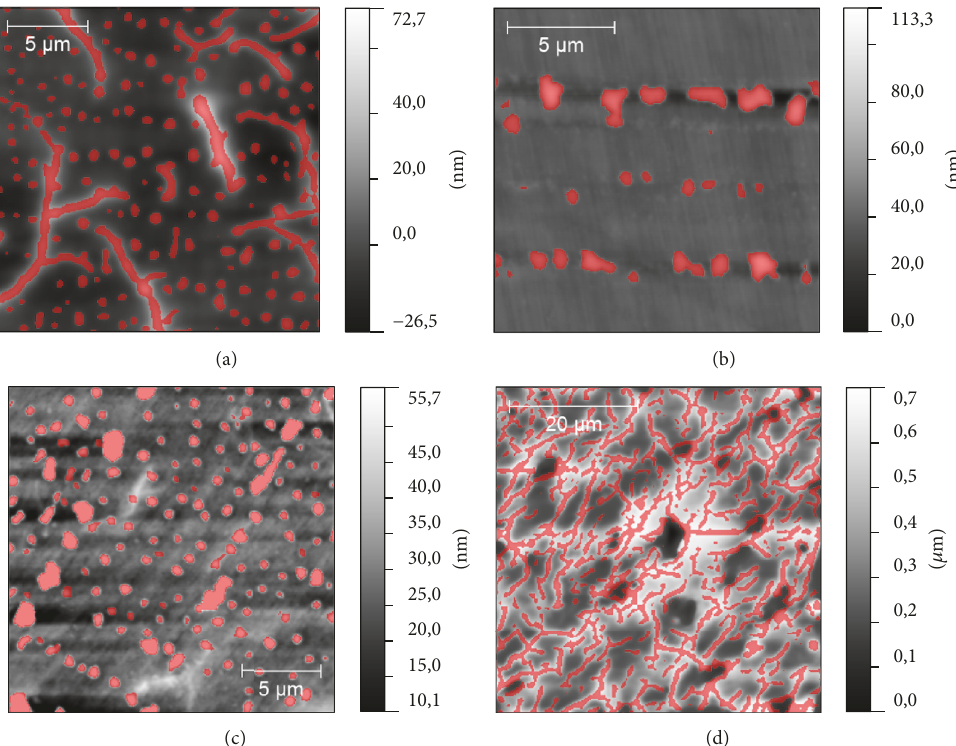
Figure 5: Surface topography of samples with dendrite-like and drop-like structures marked with color mask. (a) S4 sample: the mixed structure occupied from 15 to 20% of the surface; (b) S1 sample: jagged dots are concentrated in the scratches and occupied from 5 to 10% of surface; (c) drop-like structure of S2 sample: it occupied from 5 to 15% of surface; (d) dendrite-like structure of S2 sample: it occupied up to 30% of the surface.